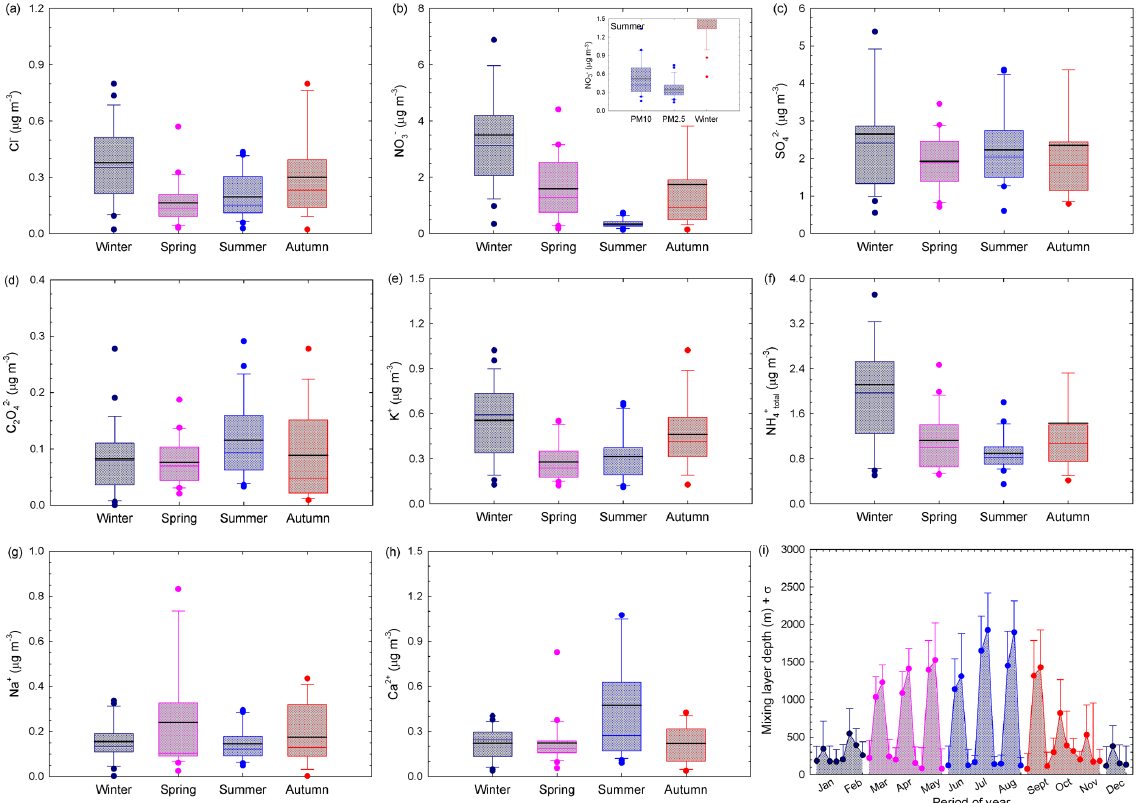
Figure 6. Seasonal variations for selected water-soluble ionic components in the PM 2 . 5 fraction (a–h) and variation in the mixing layer depth at the investigated site (i) . The inset distribution presented within NO − seasonal variation reflects the contribution of the coarse fraction over 3 the warm season. The horizontal black line represents the mean, the horizontal coloured line the median, the box the 25–75% percentiles, the length of the whiskers plot 10 and 90% of observed concentrations, and circles the